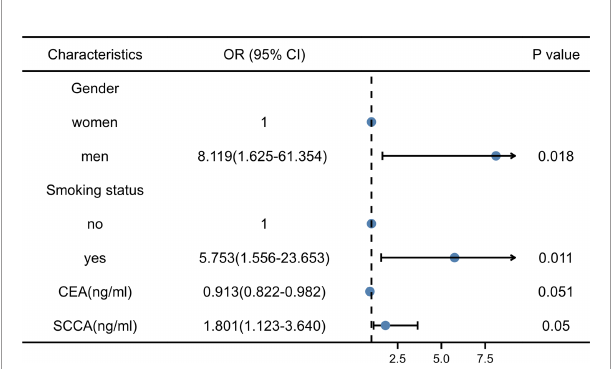
FIGURE 5 | Results of stepwise regression of clinical factors and laboratory indicators. CEA, Carcinoembryonic antigen; SCCA, squamous cell carcinoma antigen; OR, Odd ratio.